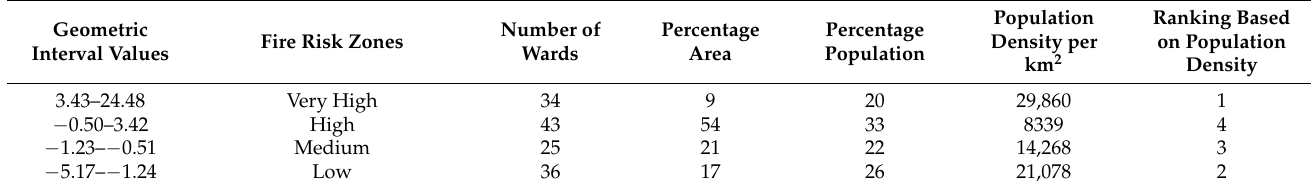
Figure 4. Hotspot from the Kernel Density Estimation . Table 2. Fire risk zone classification for KDE outputs .